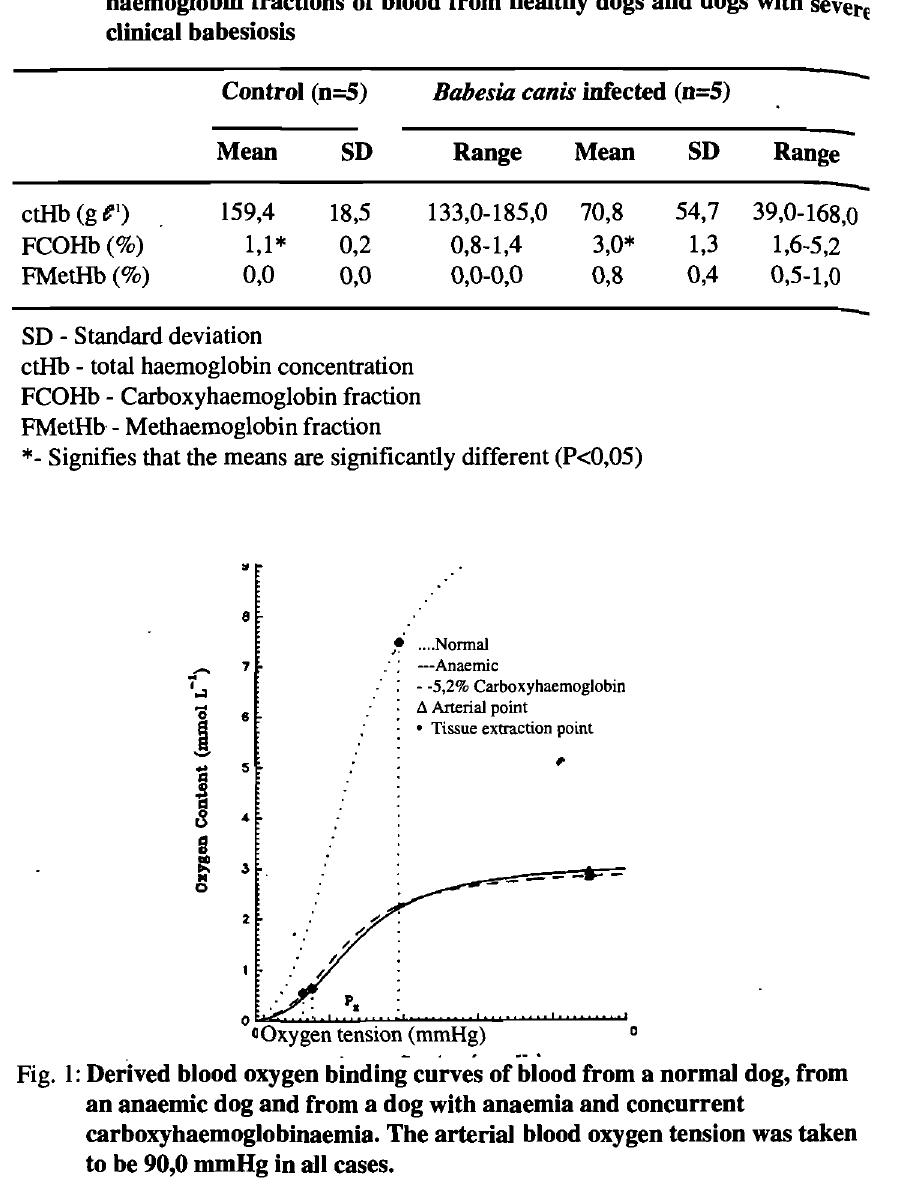
Tablel: Total haemoglobin concentration, carboxy haemoglobin and Illet. haemoglobin fractions of blood from healthy dogs and dogs with sevet~